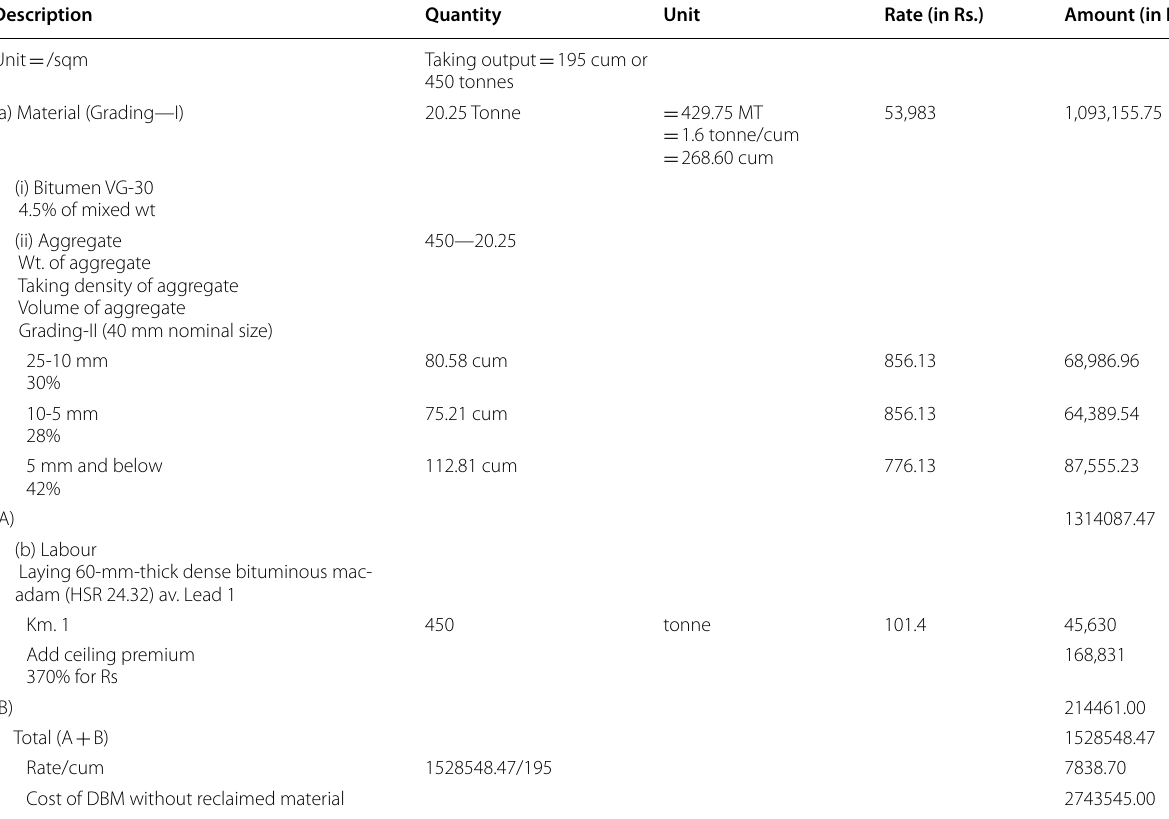
Table 8 Cost Analysis of DBM without RAP aggregates Description